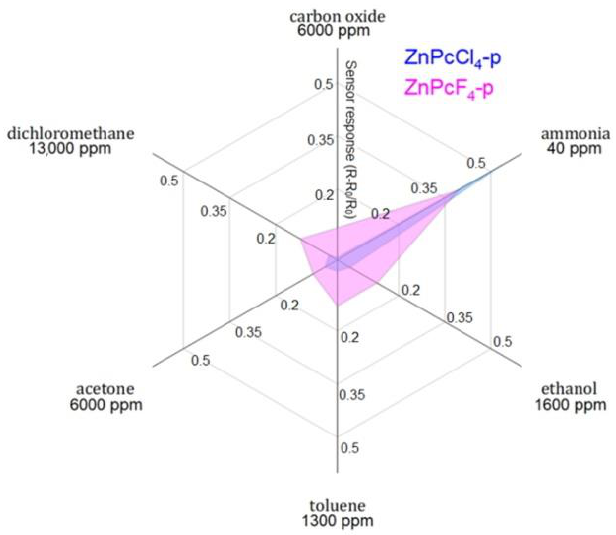
Figure 11. Diagram of selectivity of ZnPcF 4 -p and ZnPcCl 4 -p sensing layers toward various analytes, measured at room temperature and RH 10%.